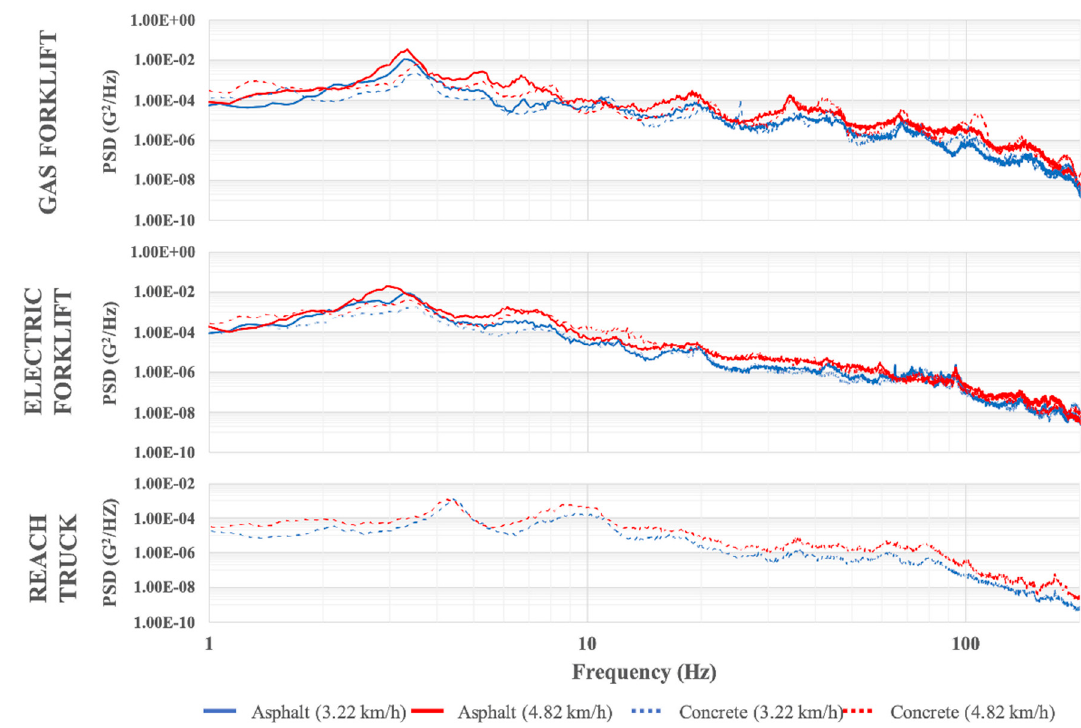
Figure 7. PSD plots of the three investigated forklifts as a function of speed (3.22 km/h, 4.82 km/h).